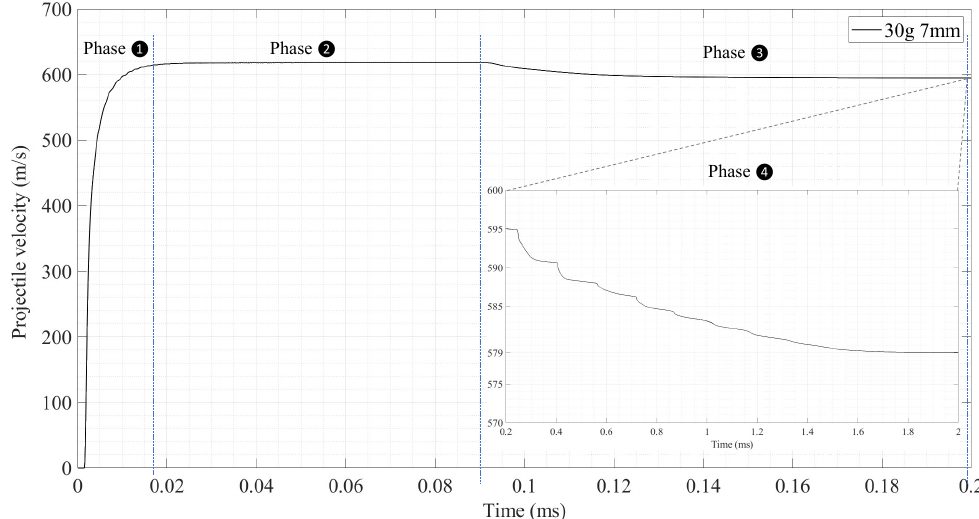
Figure 17. A graph of a typical projectile velocity evolution from the moment of detonation until its arrival at the tube’s exit (case of 30 g of C4 and 7 mm projectile